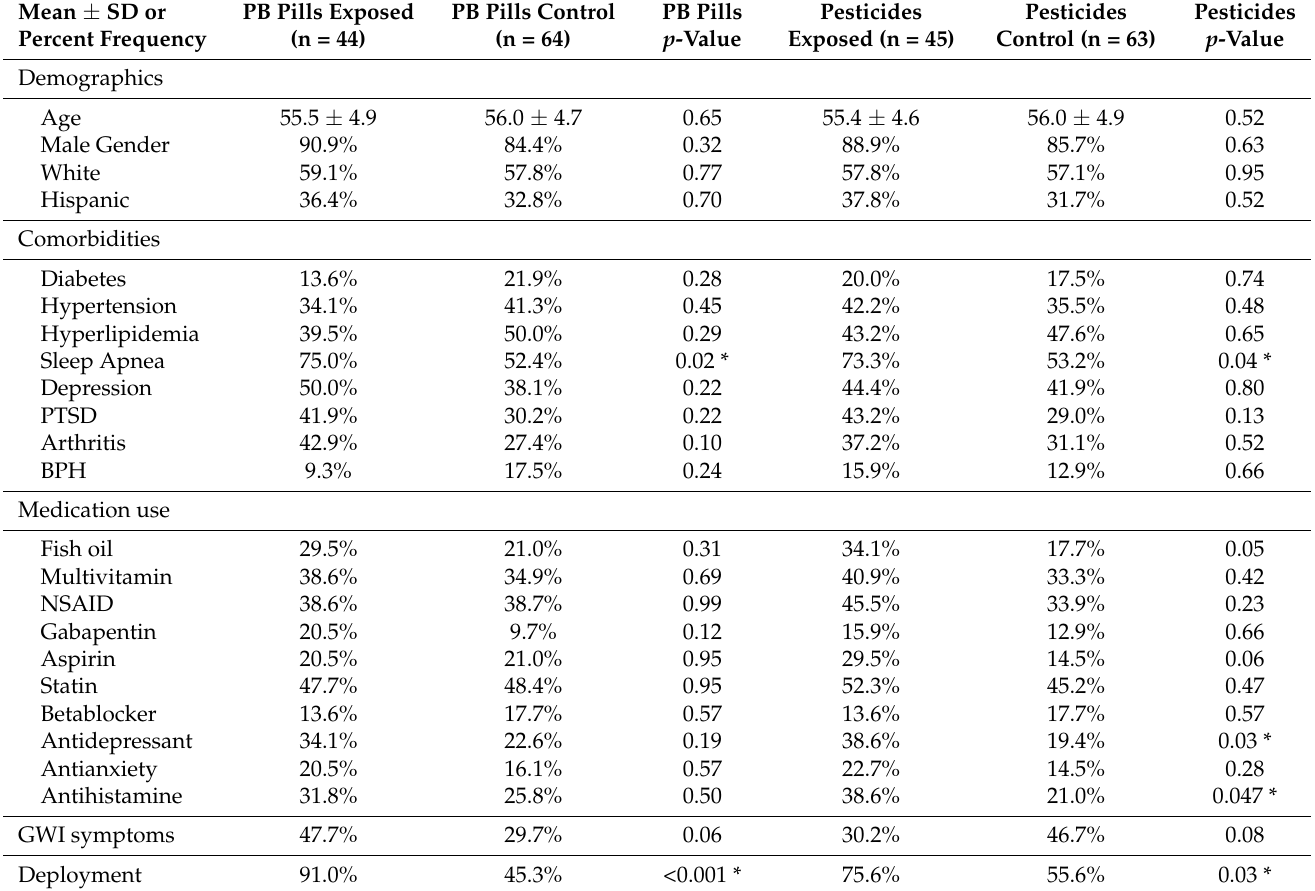
Table 1. Demographics, co-morbidities, and medication use in the study population, divided by exposure